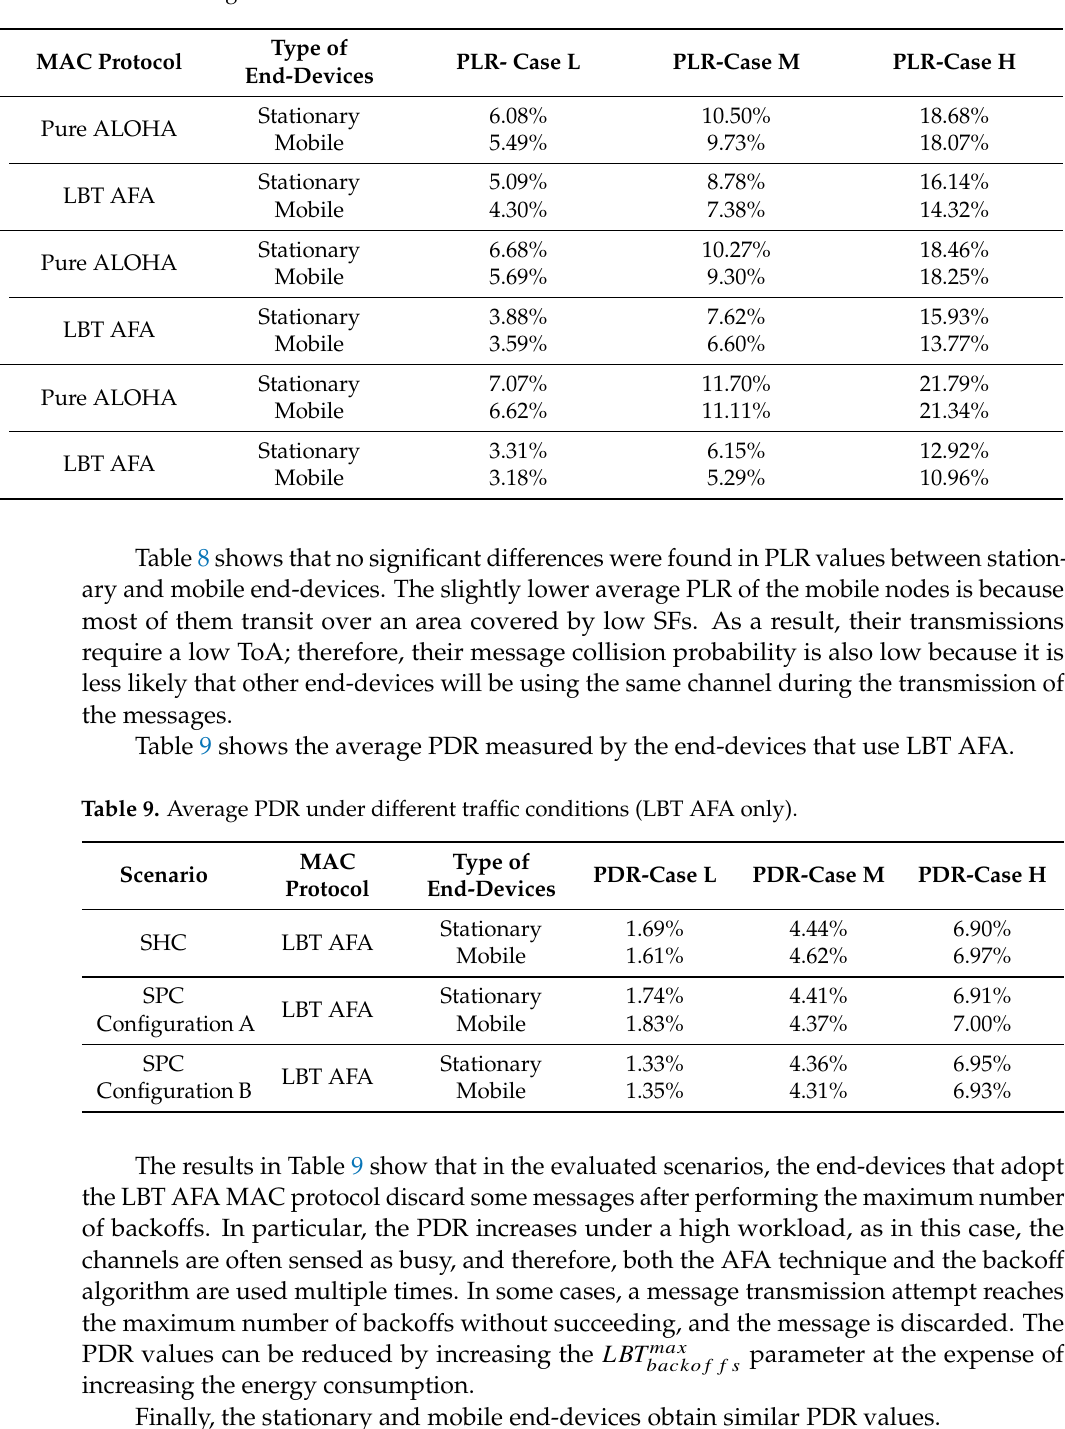
Table 8. Average PLR under different traffic conditions.